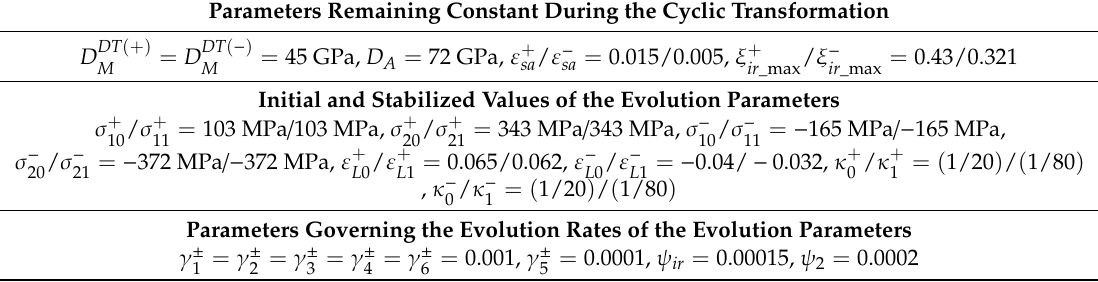
Table 3. Material parameters used in the proposed model for shape-memory SMAs at room temperature. (NiTi alloys–Ni, 50.2 at.%).